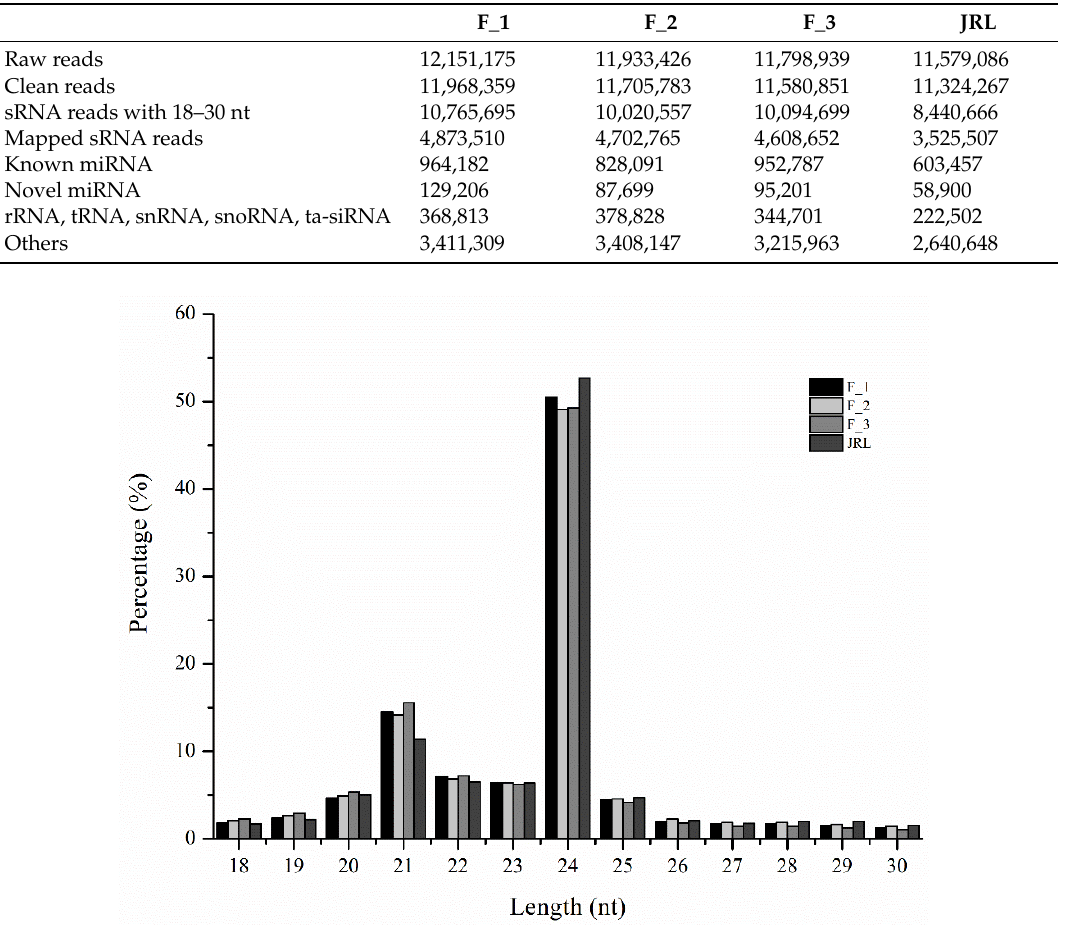
Table 1. Summary of small RNA sequencing and annotation in the four J. regia libraries. F_1, female flower buds before flower induction; F_2, female flower buds during flower induction; F_3, female flower buds after flower induction; JRL, leaf buds during flower induction.